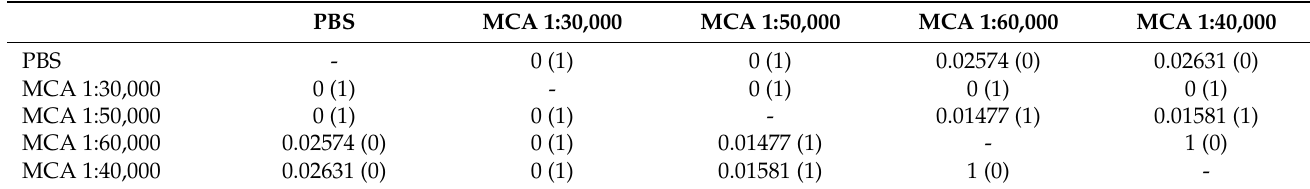
Table 3. Optimization of monoclonal anti-bodies in different concentration for sensor